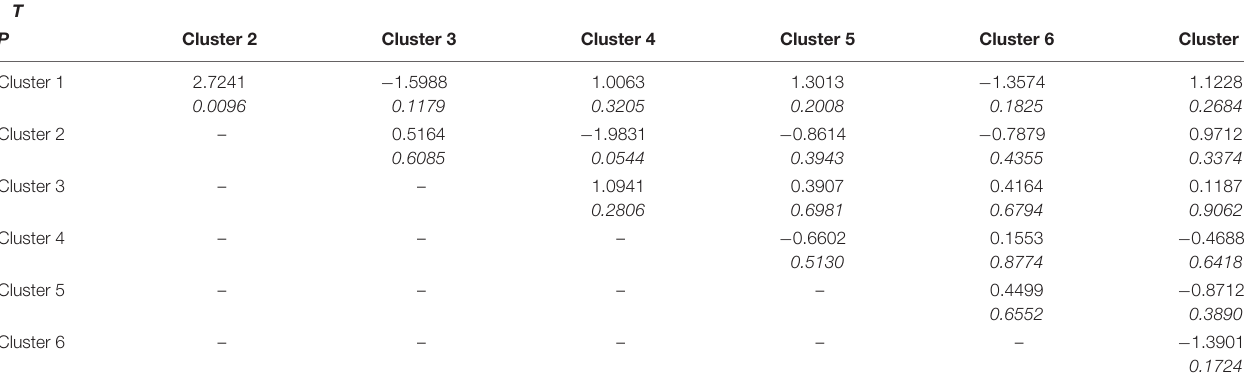
TABLE 3 | Group differences of the FC for each ROI pair between the AD and HC groups.